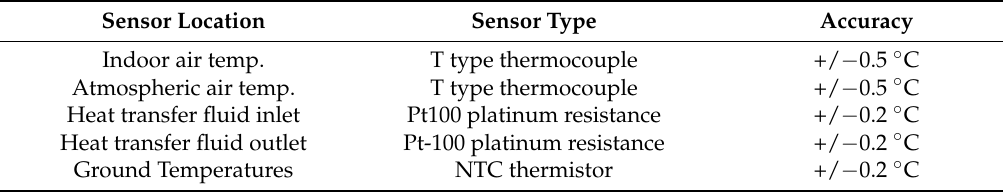
Table 2. Temperature sensor